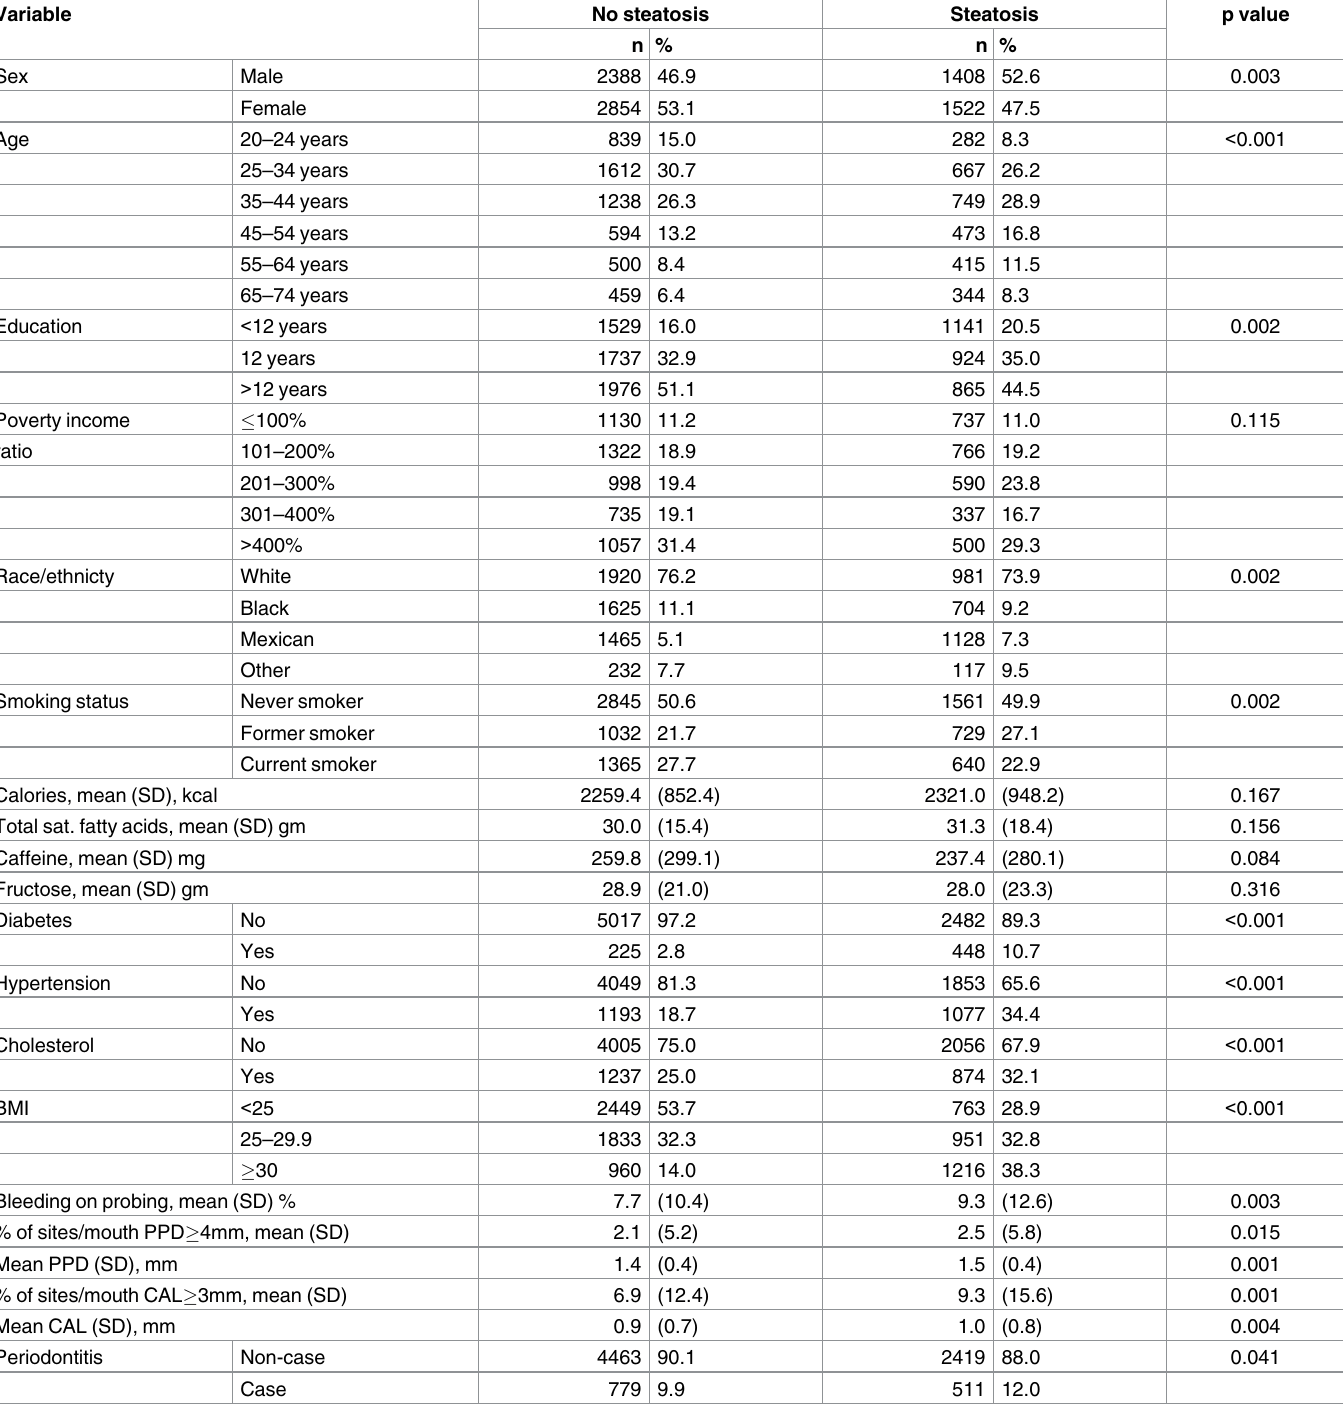
Table 1. Characteristics of respondents in NHANES III with steatosis on ultrasound and no steatosis (n = 8172).